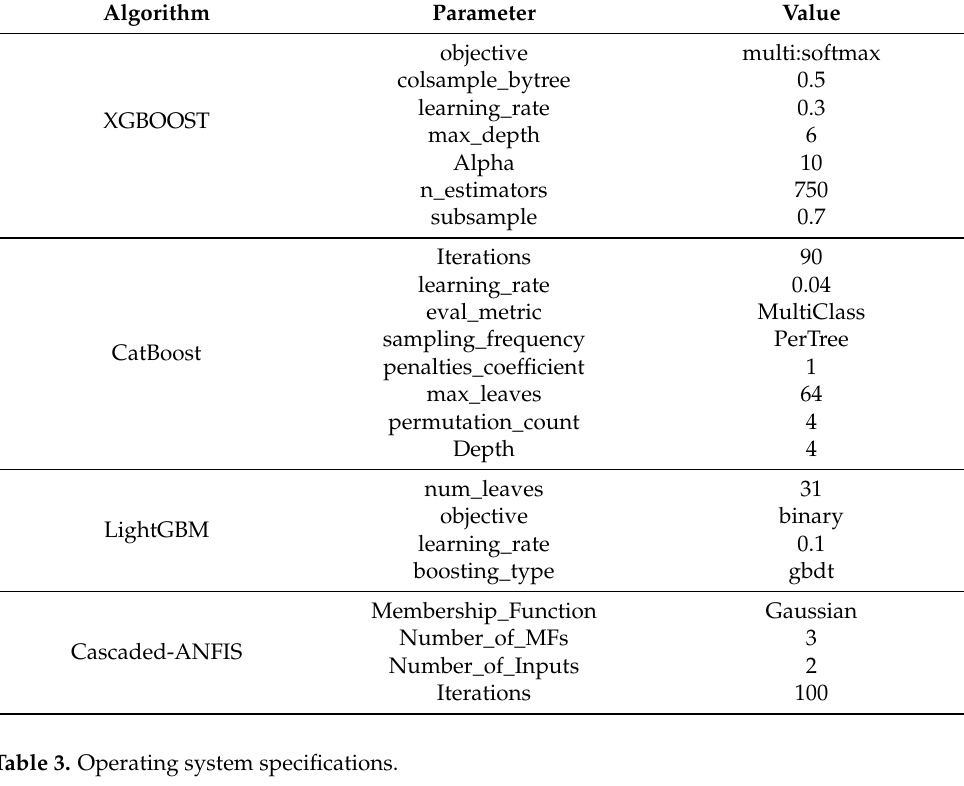
Table 2. Machine learning algorithm parameters tuned using the GridSearchCV.